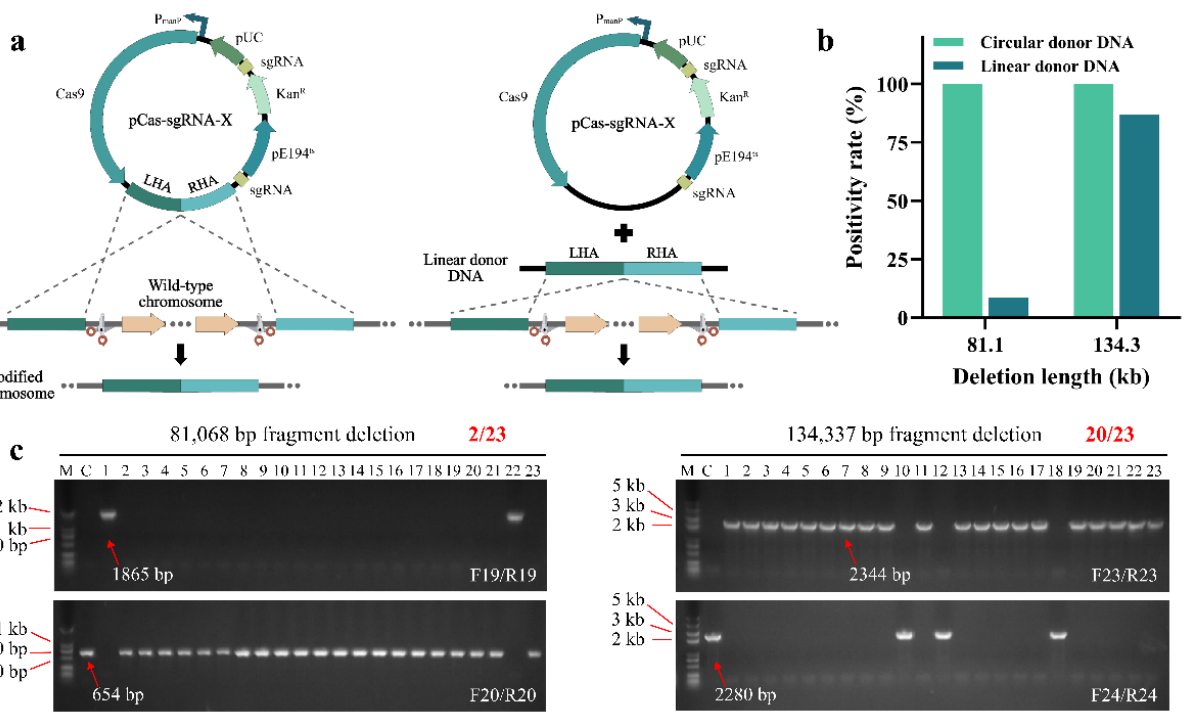
Figure 5. Long fragment deletions mediated by linear donor DNA. ( a ) The different designs of circular and linear donor DNA. ( b ) The positivity rates for 81.1 and 134.3 kb fragment deletions under different forms of donor DNA conditions. For 81.1 and 134.3 kb fragment deletions, the positivity rates mediated by the circular and linear DNA were compared. ( c ) Using linear donor DNA as repair template, PCR results were verified for 81.1 and 134.3 kb fragment